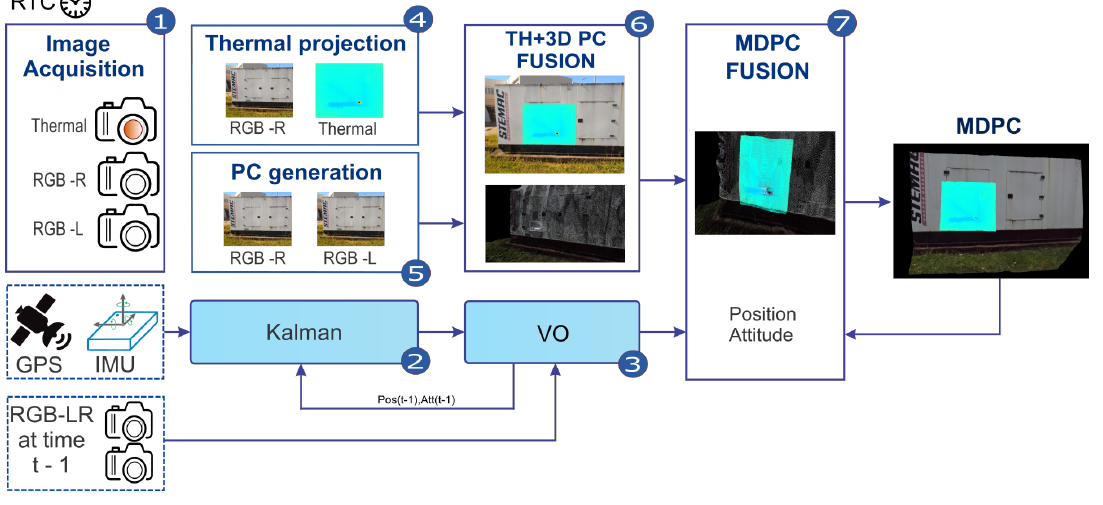
Figure 1. Methodology Diagram. Table 1. Processes description, priorities and time